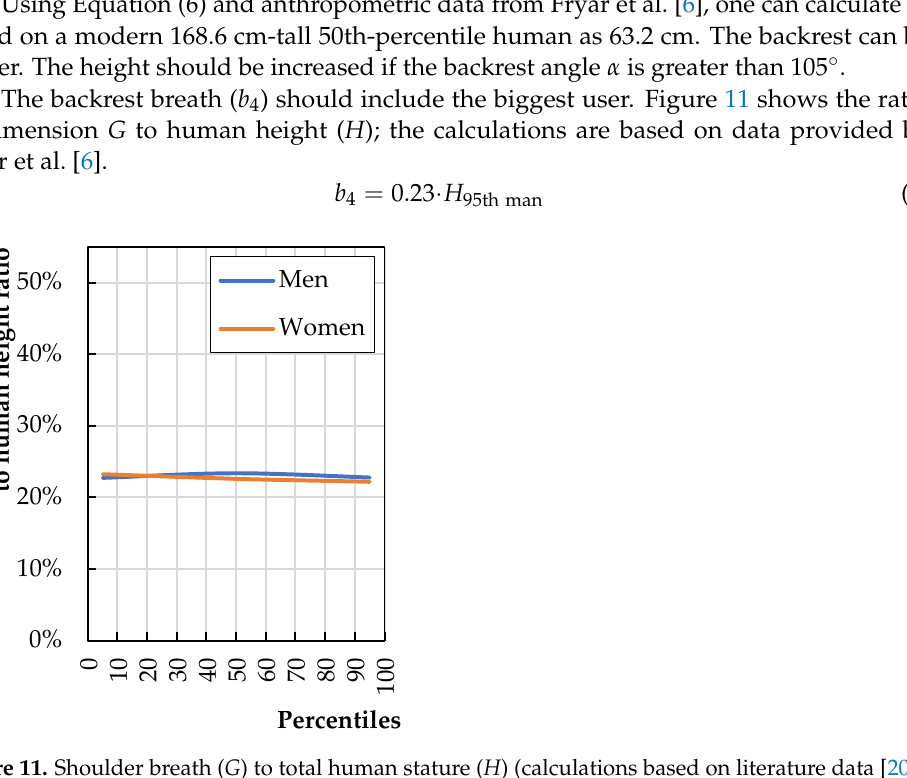
Figure 11. Shoulder breath ( G ) to total human stature ( H ) (calculations based on literature data [20]). Using Equation (7) and anthropometric data from Fryar et al. [6], one can calculate b 3 based on a modern 187.7 cm-tall 95th-percentile man as 43.2 𝑏 = 0.23 ∙ 𝐻 (cid:2872) (cid:2877)(cid:2873)(cid:2930)(cid:2918) (cid:2923)(cid:2911)(cid:2924)